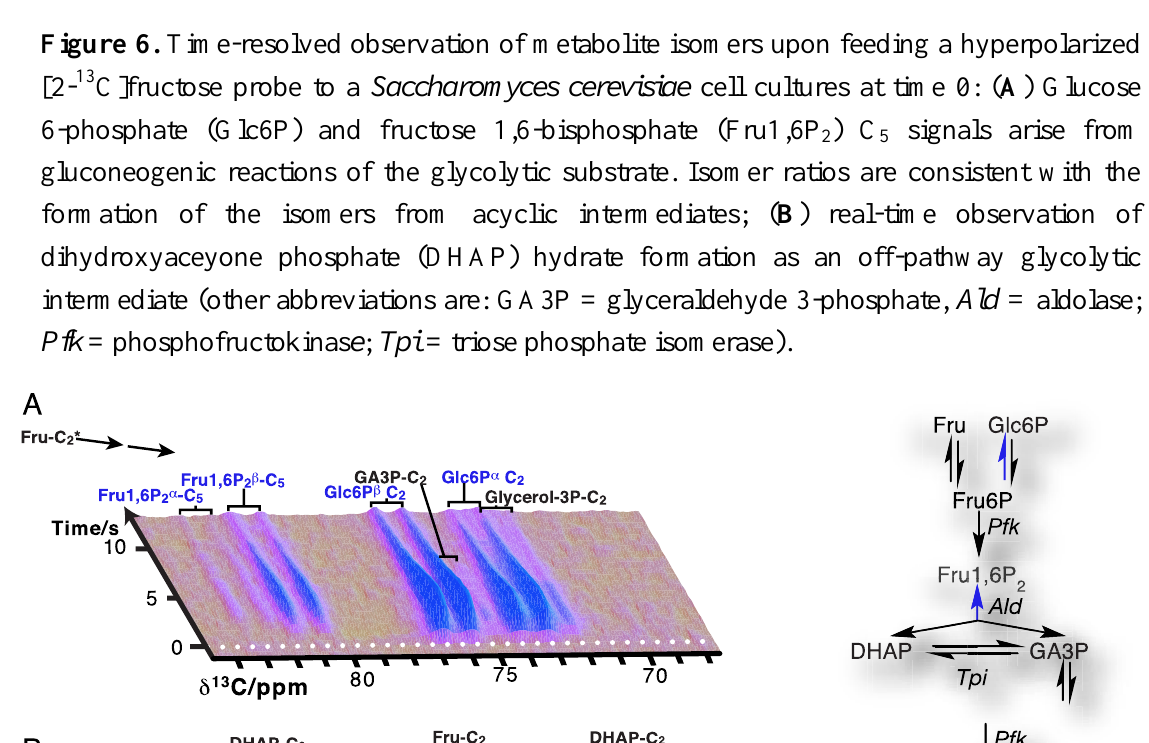
) C signals arise from 2 5